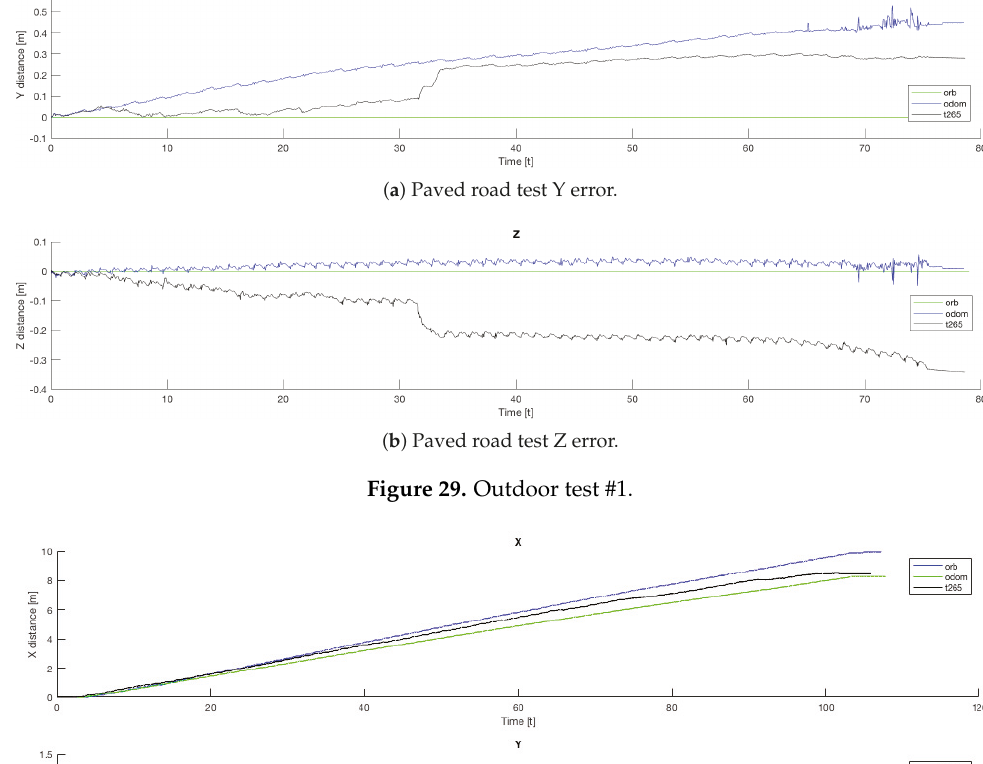
Figure 28. Outdoor test #1.